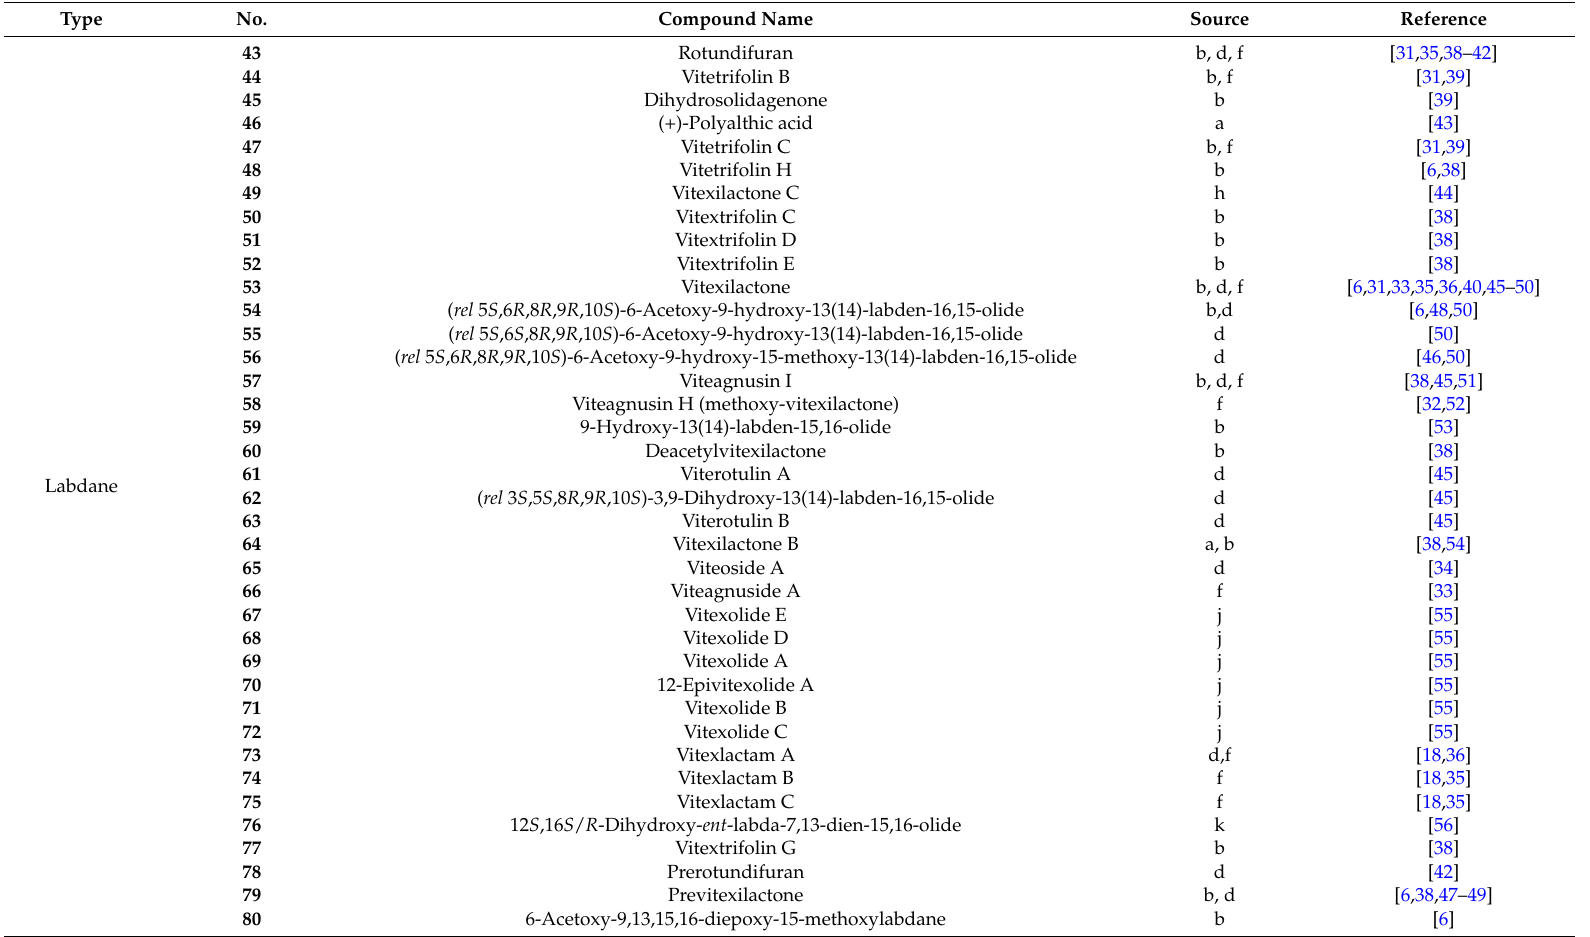
Table 3. Diterpenoids 43 – 156 isolated from plants of Vitex